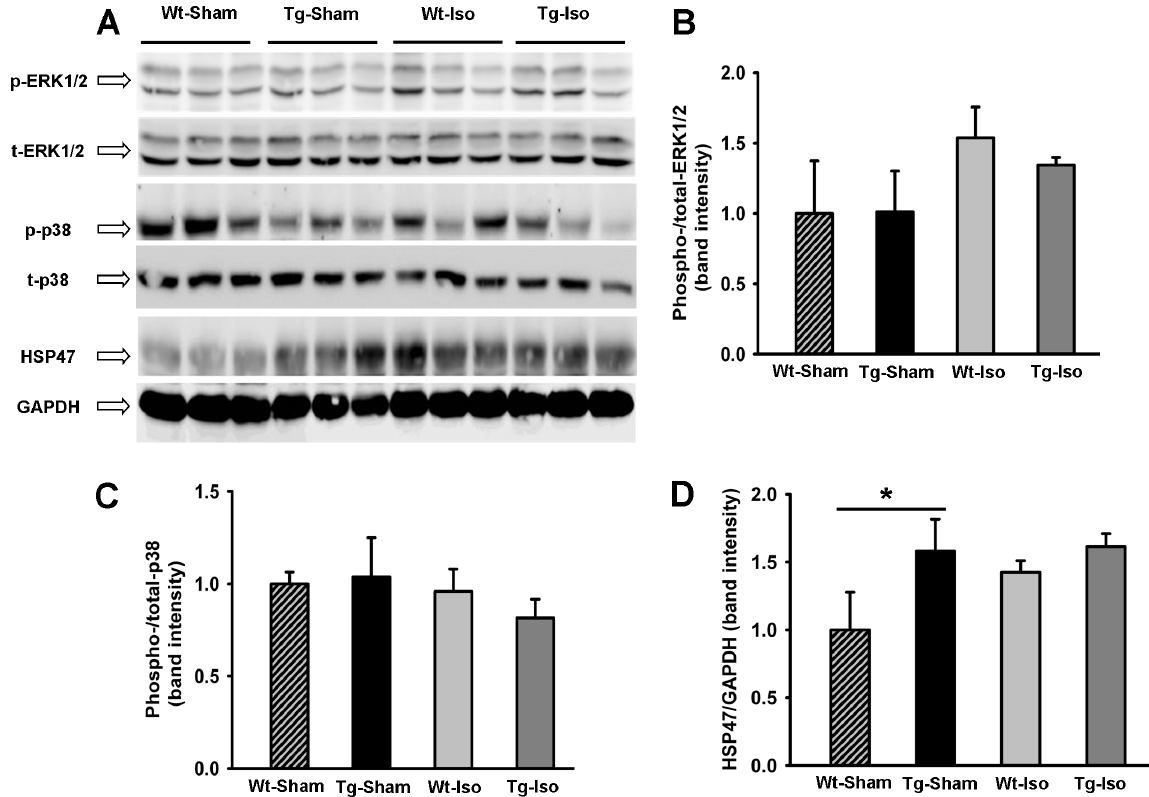
Figure 3. Western blot of ERK1/2, p-38 and HSP47. A) Western blot of the expression of ERK1/2, p-38 and HSP47 proteins from hearts of Tg and Wt mice with and without ISO treatment. B) Quantification of the ratio of phospho 2 /total Erk1/2 from hearts of Tg and Wt mice with and without ISO treatment. C) Quantification of the ratio of phospho 2 /total p-38 from hearts of Tg and Wt mice with and without ISO treatment. D) Quantification of the HSP47 protein expression from hearts of Tg and Wt mice with and without ISO treatment. * P , 0.05 , Wt vs.